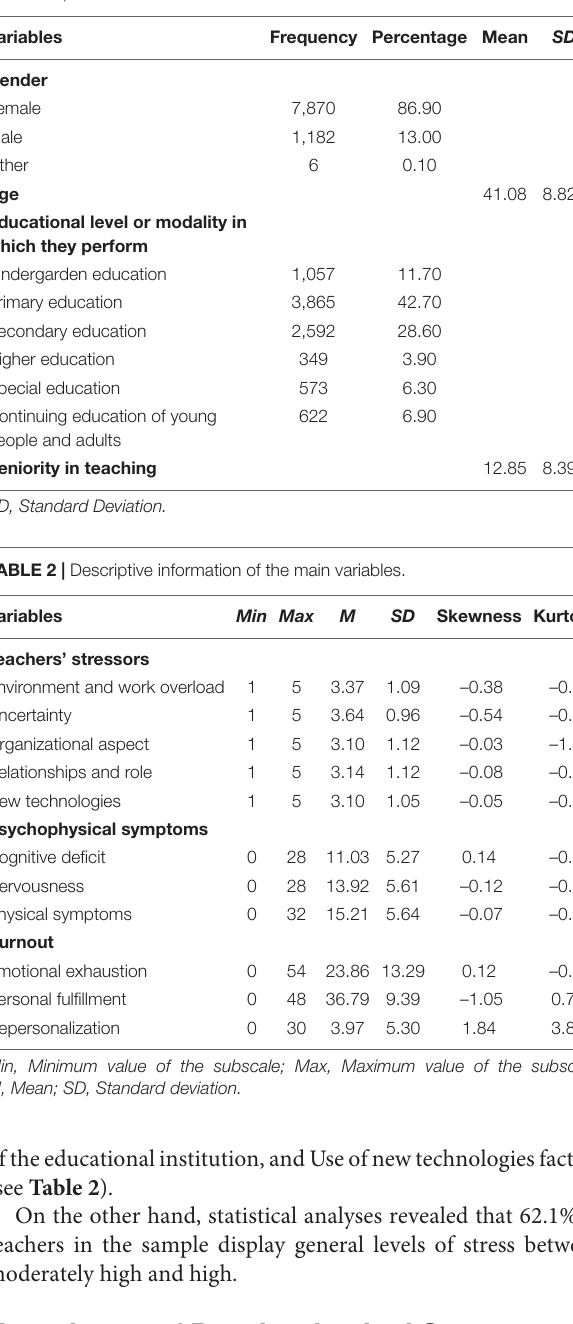
TABLE 1 | Demographic and working characteristics of the participants ( n = 9.058).